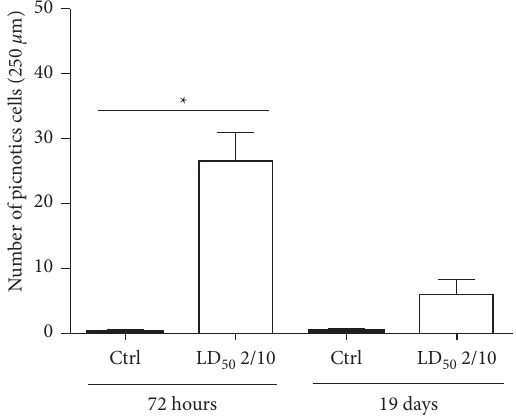
Figure 4: Cell count of pyknotic cells in the DG of rats administered the neonicotinoid mixture (LD applied 72h after the last dose. The pyknotic cells quantified were higher and statistically significant ( P � 0 . 0125) when compared to their respective control ( n � 5). The DG cells from the rats killed 19 days after the last dose showed a less severe effect ( n �